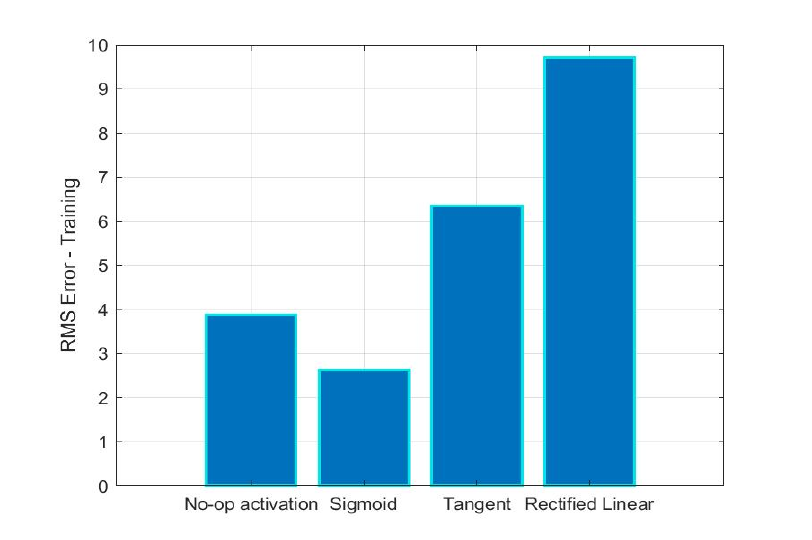
Figure 5. RMS error with activation functions